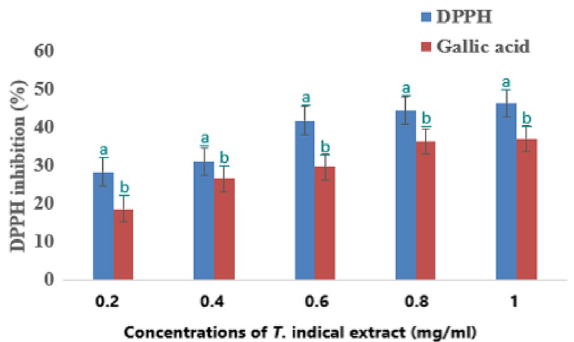
Figure 2. DPPH radical scavenging activity (%) (Mean + Standard deviation) of T. indica fruits extract.